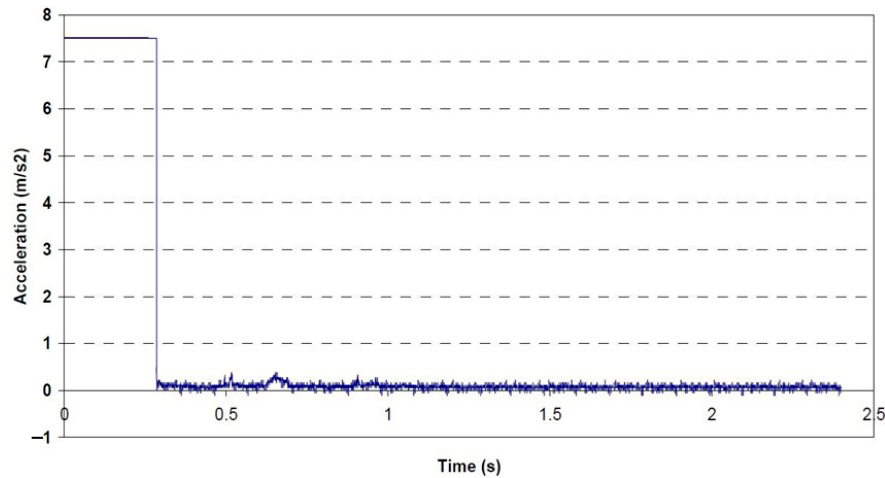
Figure 13. Input motion for centrifuge test with 80× g acceleration [31].